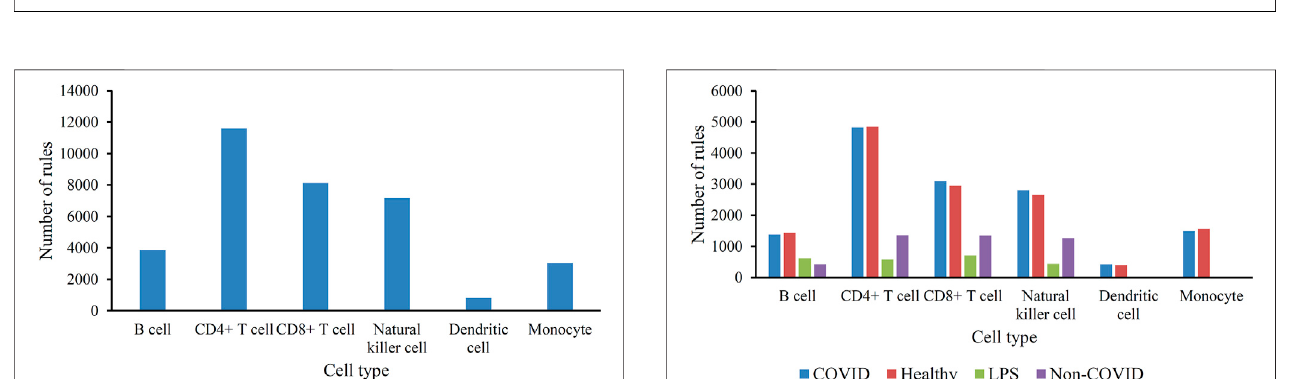
FIGURE 3 | Performance of the optimal classi fi ers in all categories (disease status) in each cell type. (A) Performance of the optimal classi fi ers in B cells; (B) performance of the optimal classi fi ers in CD4 + T cells; (C) performance of the optimal classi fi ers in CD8 + T cells; (D) performance of the optimal classi fi ers in natural killer cells; (E) performance of the optimal classi fi ers in dendritic cells; and (F) performance of the optimal classi fi ers in monocytes.